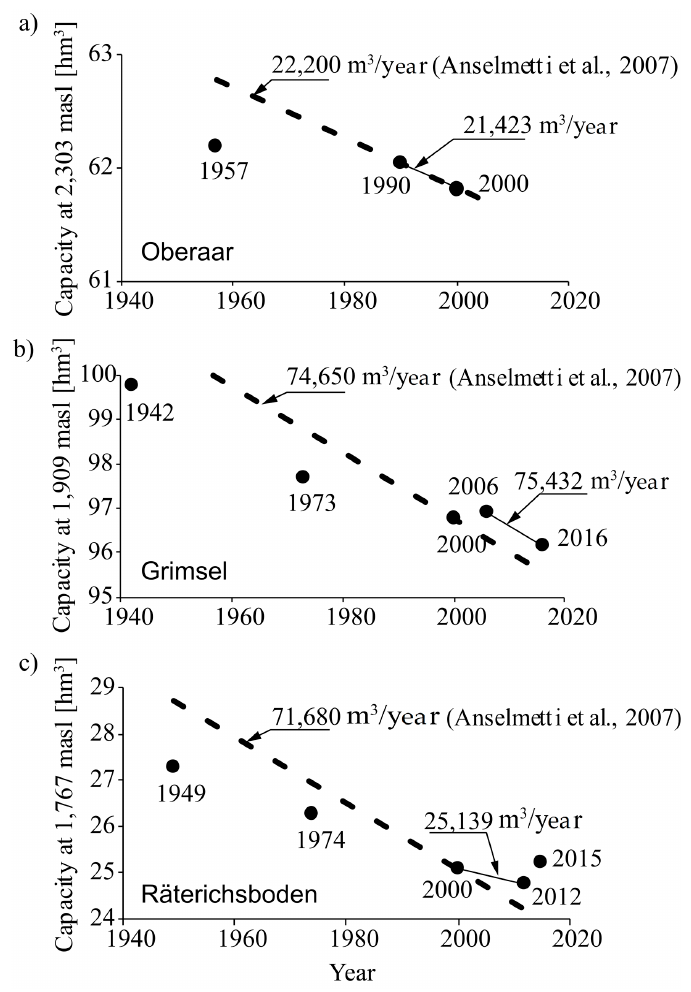
Figure 4. Sedimentation rates estimated from bathymetric surveys and those reported by Anselmetti et al. (2007) for: ( a ) Oberaar; ( b ) Grimsel; and ( c )